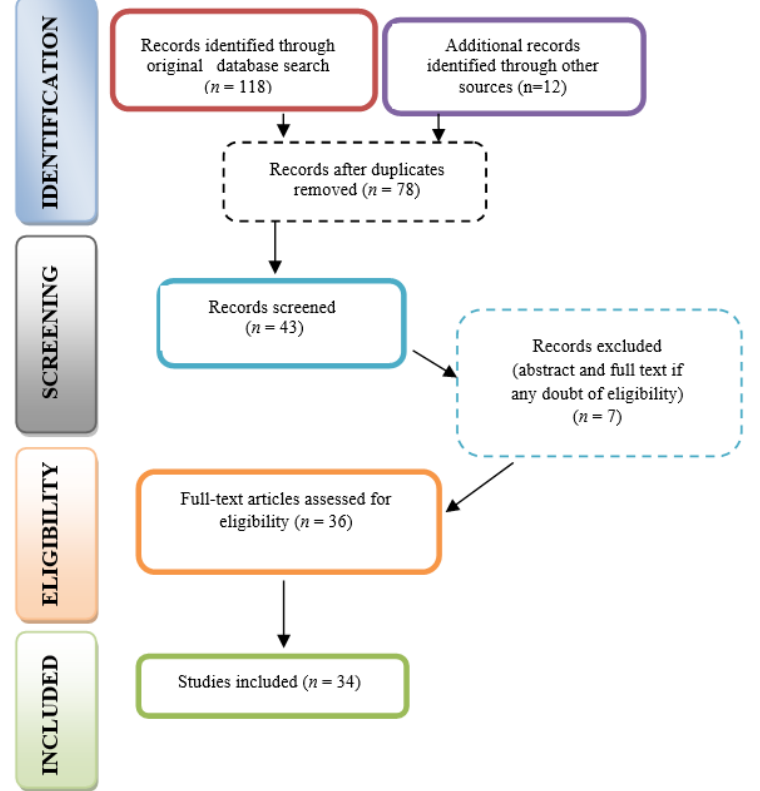
Figure 2. PRISMA flow diagram for research stages.